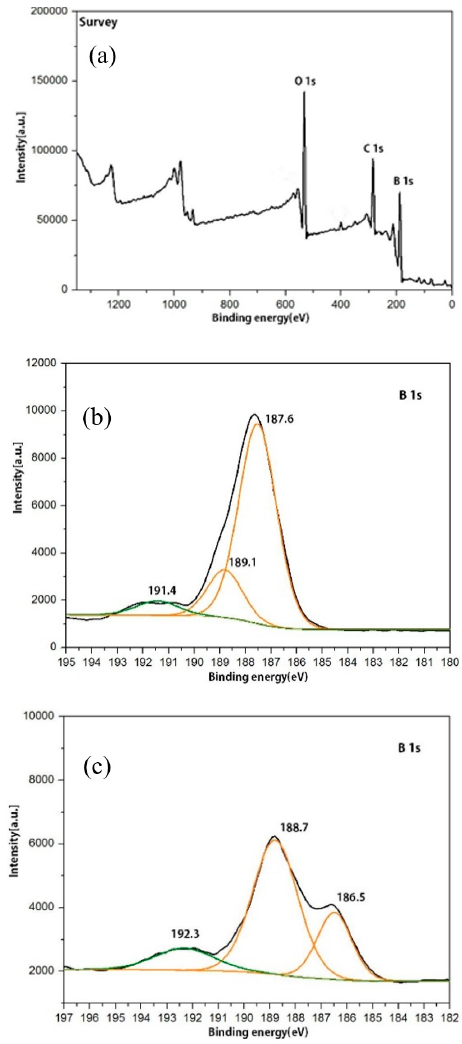
Figure 3. XPS results of boron powder before and after grinding ( a ) Full-scale survey ( b ) Before grinding, breakdown drawing of B 1s peak ( c ) After grinding, breakdown drawing of B 1s peak.